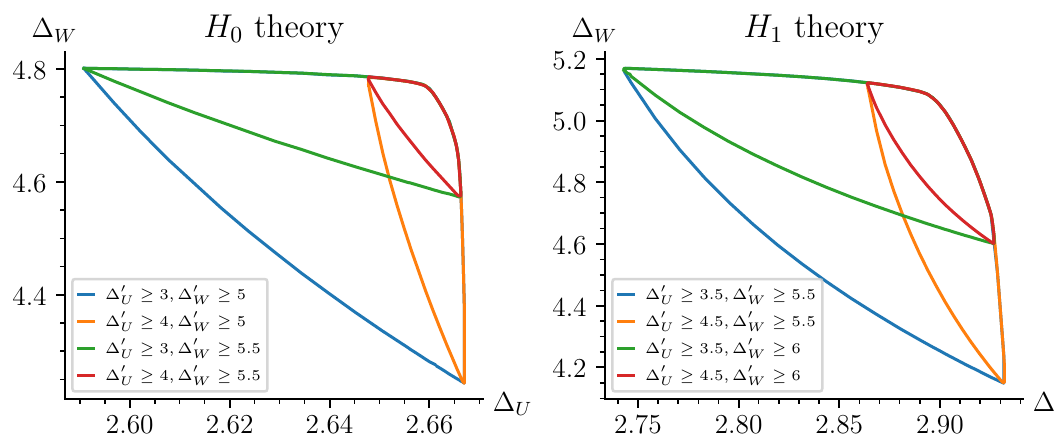
Figure 2 . Dimension ∆ U of the lowest dimension unprotected operator in the ϕ × ¯ ϕ channel, versus dimension ∆ W of the lowest dimension unprotected operator in the ϕ × ϕ channel. We fix the dimension of the external operator ϕ and the central charge c , and impose gaps with the next operators in the spectrum ∆ 0 and ∆ 0 . All bounds have been obtained with cutoff Λ = 32 U W